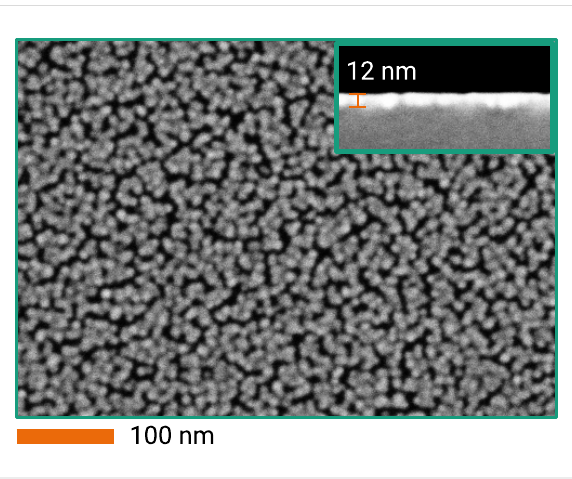
Figure 2: SEM surface images after 90 cycles of Ir ALD. The inset shows the corresponding cross section.